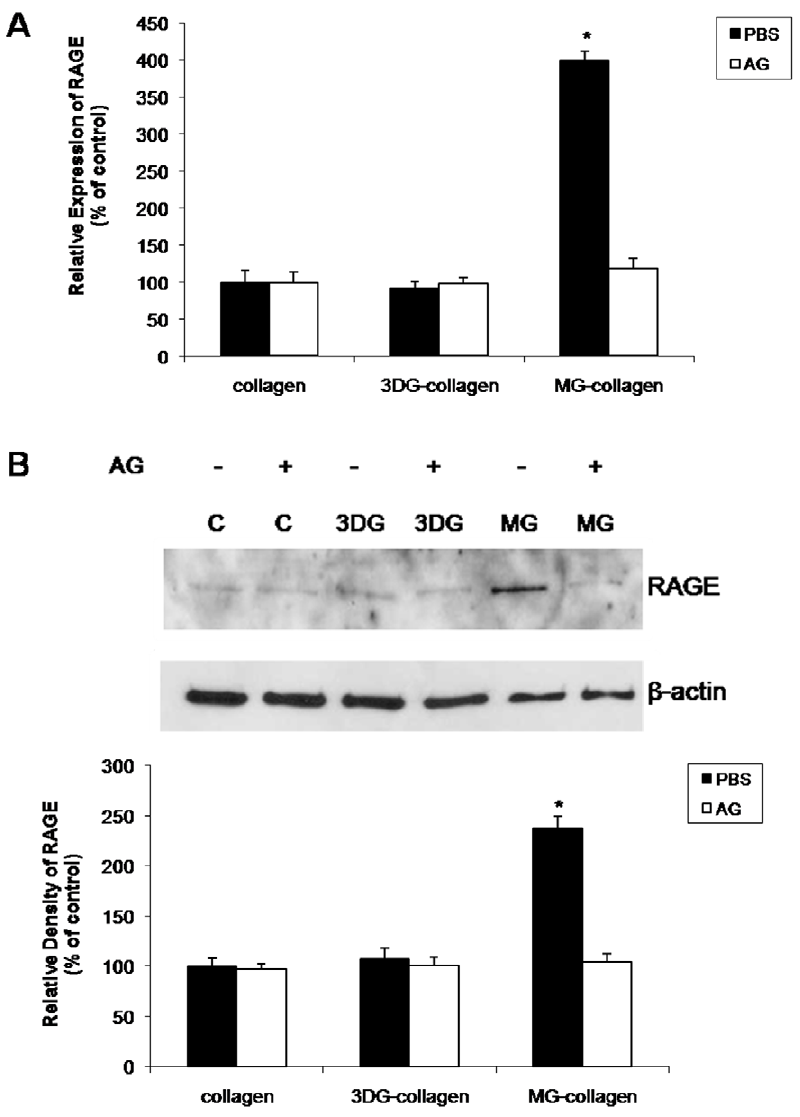
Figure 8. 3 DG-collagen does not induce the expression of RAGE. A , Fibroblasts were cultured on native collagen, 1 mM 3 DG-collagen, or 1 mM MG-collagen with or without 5 mM AG for 24 h. mRNA was analyzed for the expression of RAGE by real-time PCR. All transcripts were normalized to b -actin. B , Fibroblasts were treated as in A and analyzed for the expression of RAGE by Western blot. The bars correspond to the densitometric value of RAGE after normalization for b -actin. All comparisons are made against collagen treated with PBS. Data are mean 6 SD (n=3), *P , 0.002.